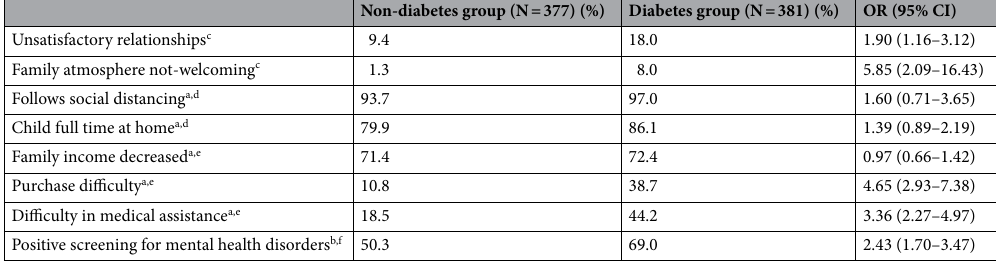
Table 2. Support, relationships, and consequences of social distancing in study participants. Data are prevalence (%) and odds ratio (OR) with confidence interval (95%). An OR greater than 1 means that there was an increase in likelihood to present the psychosocial characteristic evaluated in the diabetes group in relation to the non-diabetes group (OR for comparator = 1). All OR are adjusted for age of the child, race/ ethnicity, income and region of origin. a In relation to the period after the beginning of the COVID-19 pandemic. b Positive screening for mental health disorders accessed by a score greater than or equal to 7 on the SRQ-20. c n = 383 for non-diabetes group and n = 377 for diabetes group. d n = 383 for non-diabetes group and n = 331 for diabetes group. e n = 378 for non diabetes group and n = 326 for diabetes group. f n = 374 for non- diabetes group and n = 323 for diabetes group.